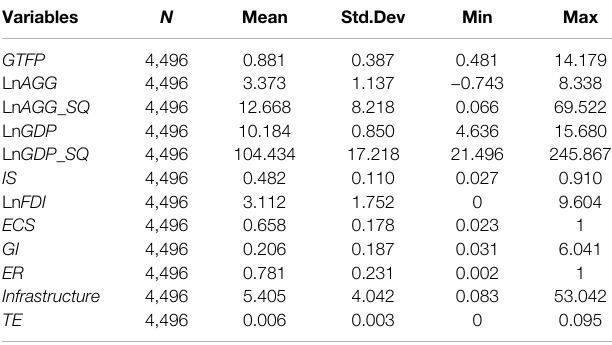
TABLE 1 | Descriptive statistics of the variables.